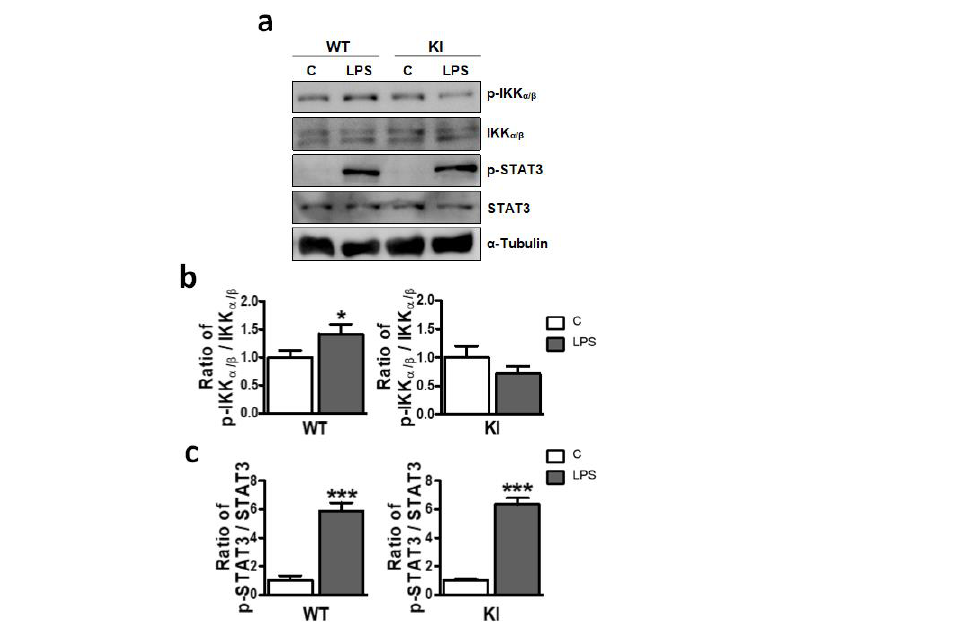
Figure 6. Failure to inactivate GSK3 β by Ser 389 phosphorylation differently affects NF- κ B and STAT3 signaling in LPS-treated mice. Activation of the NF- κ B and STAT3 pathways were examined in whole-cell lysates from hippocampus 4 h after i.p. injection of LPS (0.5 mg/kg) or vehicle (C) in both WT and GSK3 β Ser 389 KI mice. Blots illustrate the Western blot analysis of phospho-IKK α / β , total IKK α / β , phospho-STAT3, and total STAT3. ( a ) α -tubulin detection was included as a loading control. Associated graphs correspond to ( b ) phospho- IKKα/β/IKKα/β and ( c ) phospho-STAT3/STAT3 ratios, obtained from the densitometric analysis of Western blot bands. Student t-test was applied to compare untreated controls (C) and LPS-treated animals in each genotype (mean ± S.E.M, n = 5–6). *, p < 0.05; ***, p < 0.001. Data are representative of four independent experiments for pIKK/IKK and three independent experiments for pSTAT3/STAT3. WT, wild-type; KI, GSK3 β Ser 389 knockin; i.p., intraperitoneal; C, vehicle; LPS,